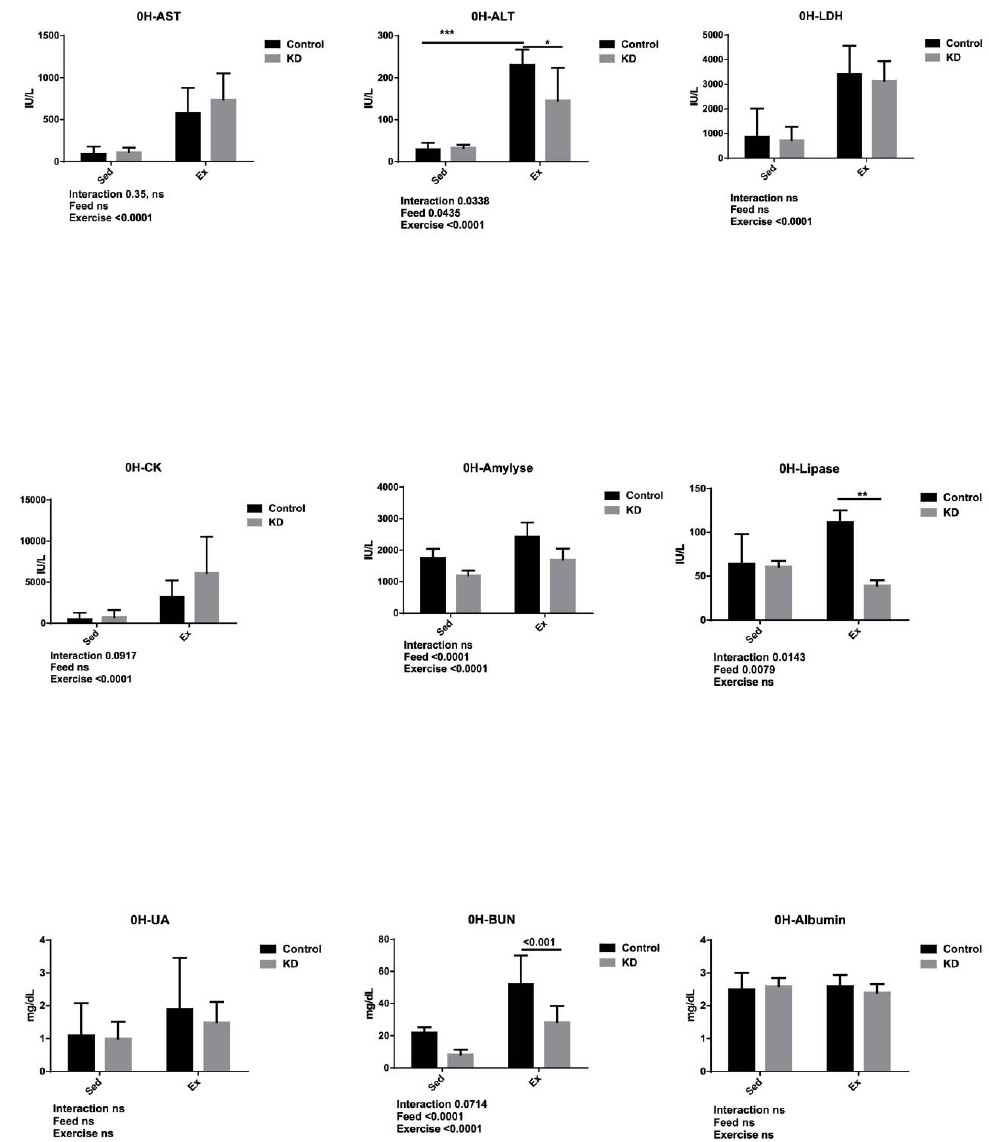
Figure 4. Plasma biochemistry results after KD feeding and immediately after exhaustion as indicated. * p < 0.05, ** p < 0.01, *** p < 0.001.